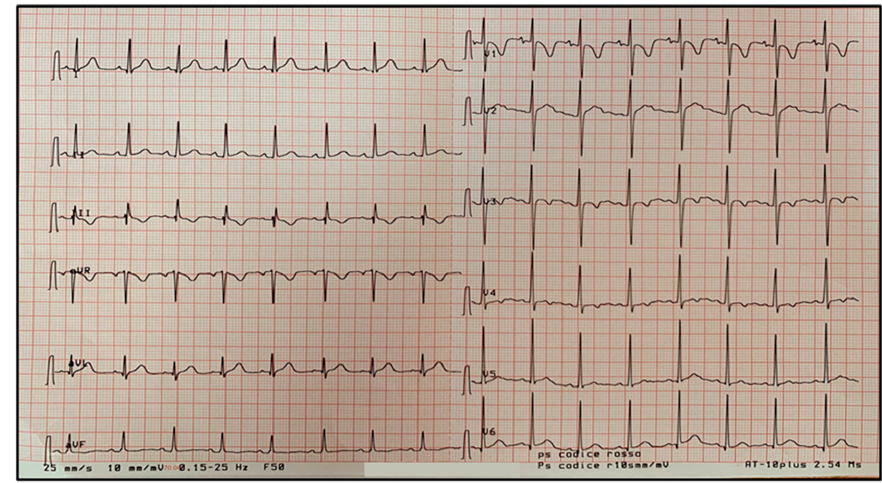
Figure 6. Complete ECG normalization after 7 days of MIS-C treatment according to current guidelines.